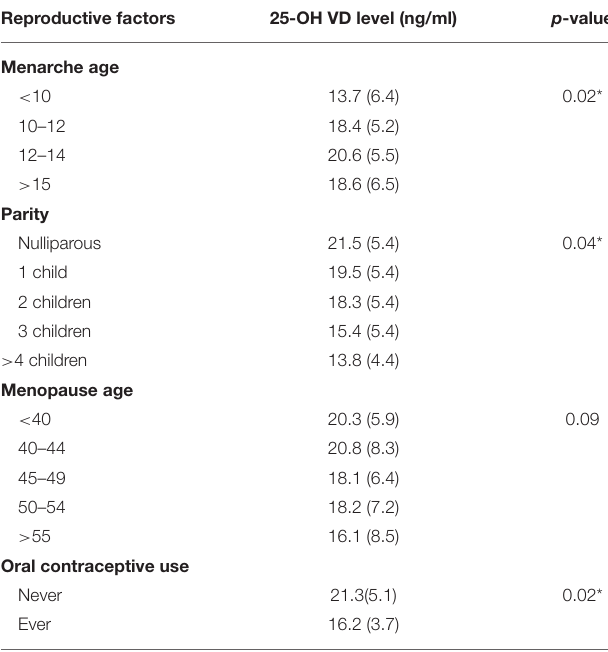
TABLE 3 | 25-hydroxyvitamin D [25(OH) D] status in CRC patients. Parameters